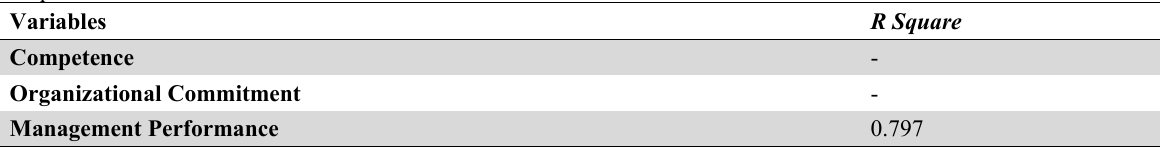
R-Square Variables R Square Organizational Commitment Management Performance Sources: SmarPLS 3.3